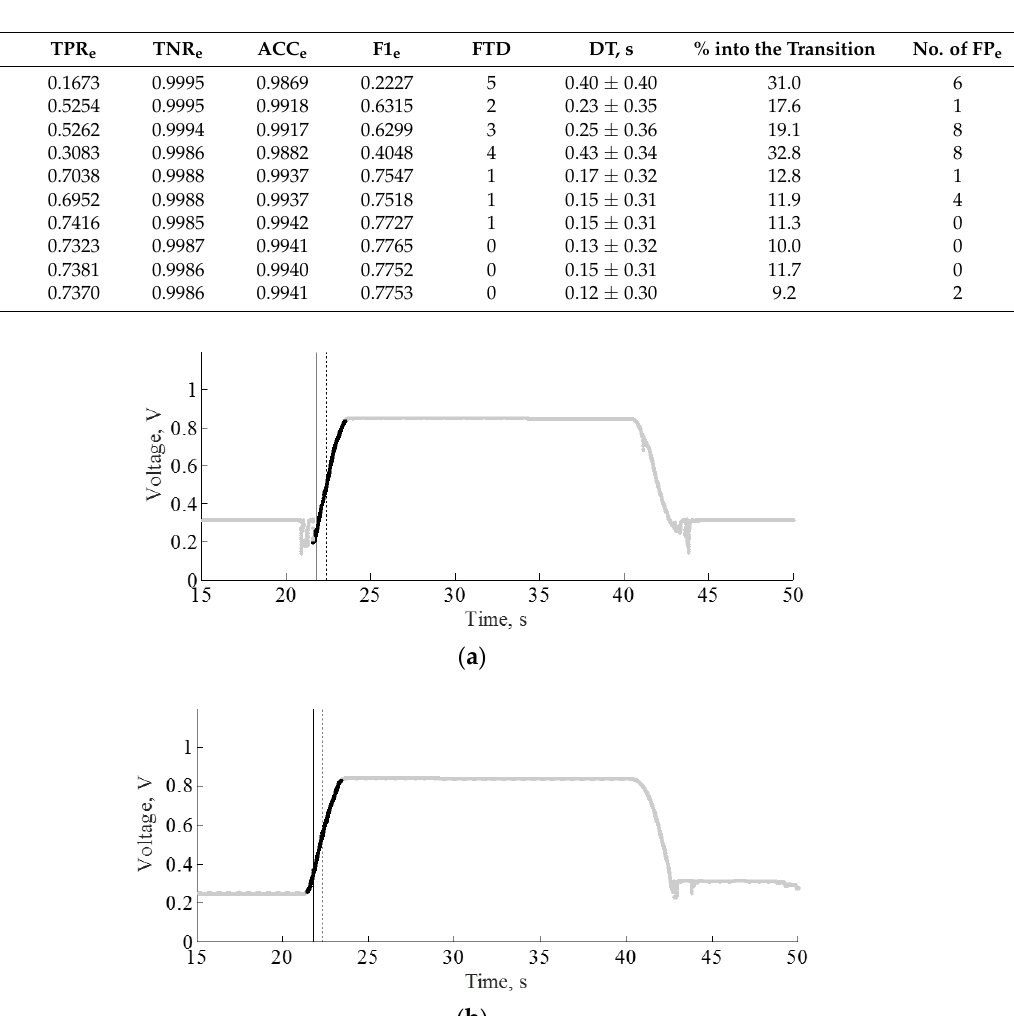
Table 5. Evaluation of MLP model.